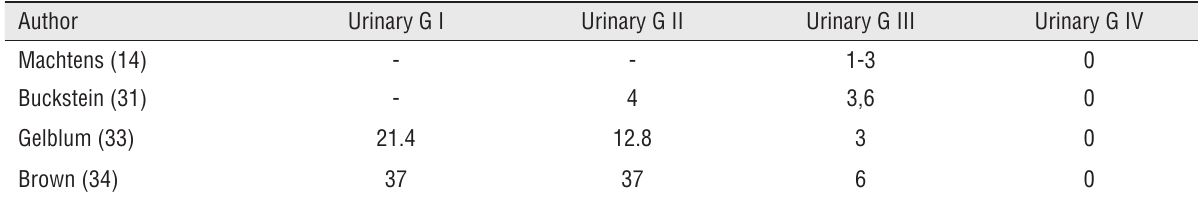
Table 7 - Urinary toxicity after brachytherapy reported by Buckstein, Machtens, Daphna and Brown. No patients had grade IV toxicity. Low grade urinary toxicity is frequently seen but is self-limiting and 90% of the patients will have a normalization of their urinary complaints 1 year post-brachytherapy.